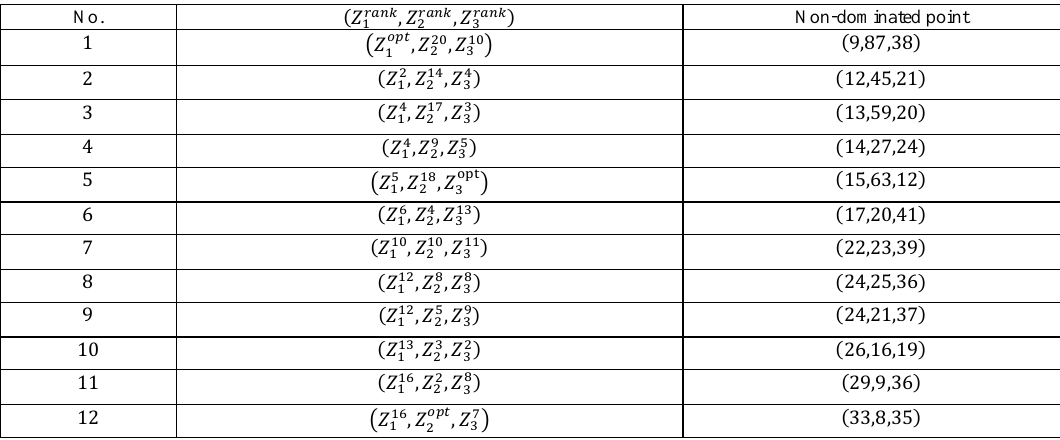
Table 11. All non-dominated